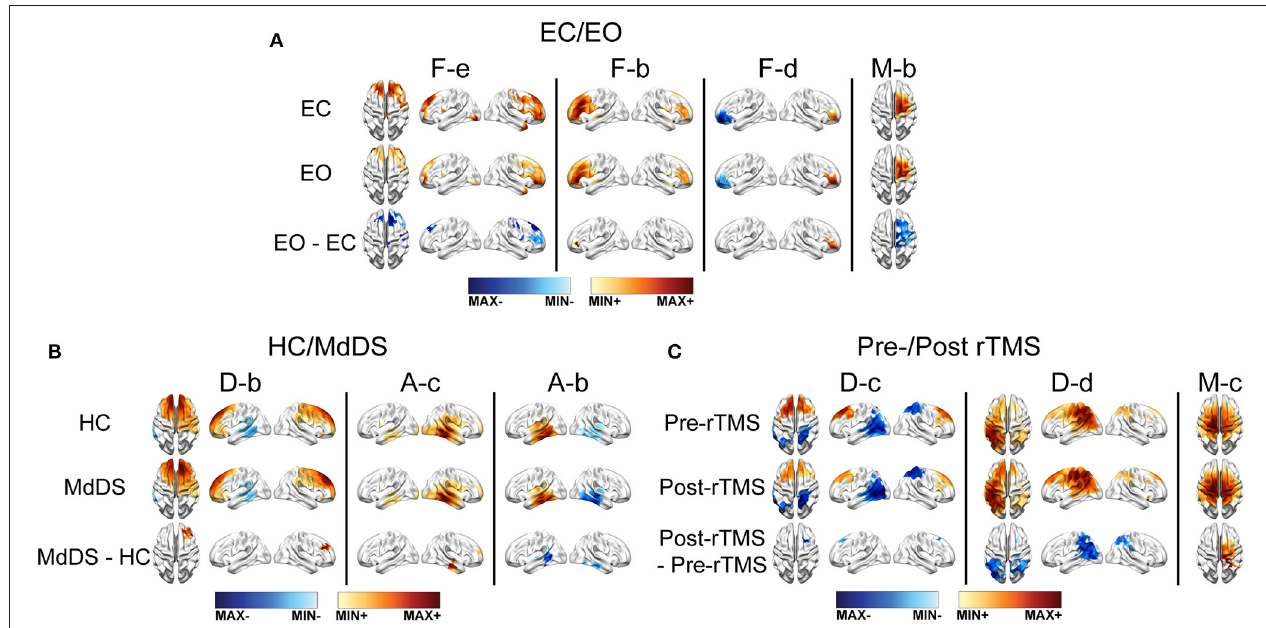
FIGURE 7 | SCT differences between data from two conditions in one dataset. (A) EC/EO. (B) HC/MdDS. (C) Pre-/Post-rTMS. Maps were thresholded p < 0.01, cluster-based